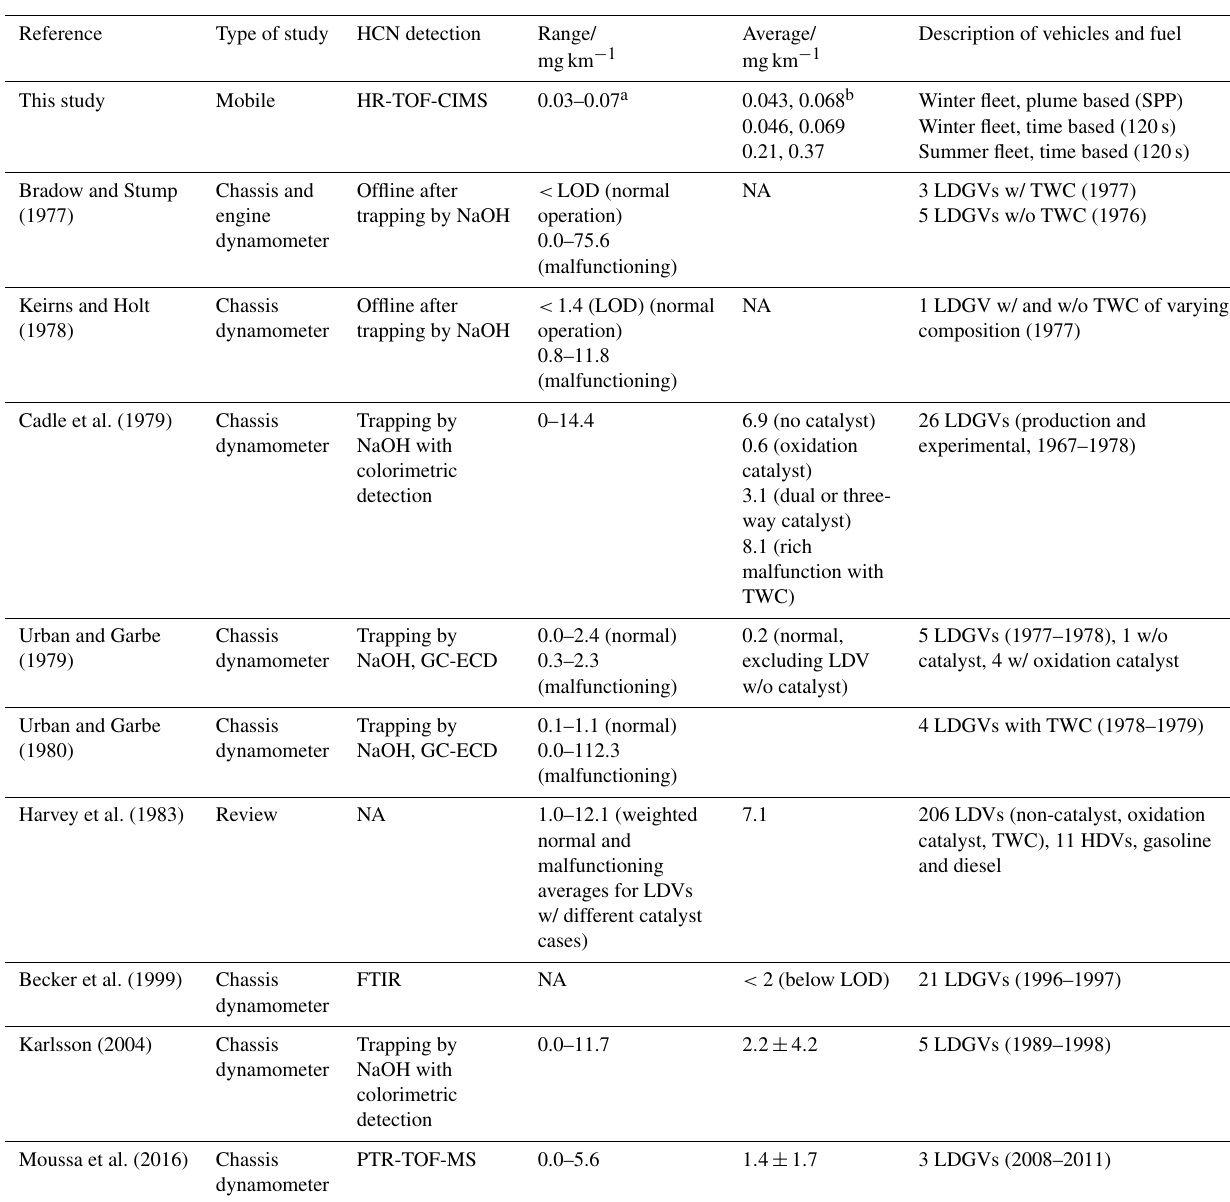
Table 4. Comparison of literature HCN emission factors from the exhaust of various gasoline- and diesel-fueled engines in distance-based units (mgkm − 1 ). NA stands for “not